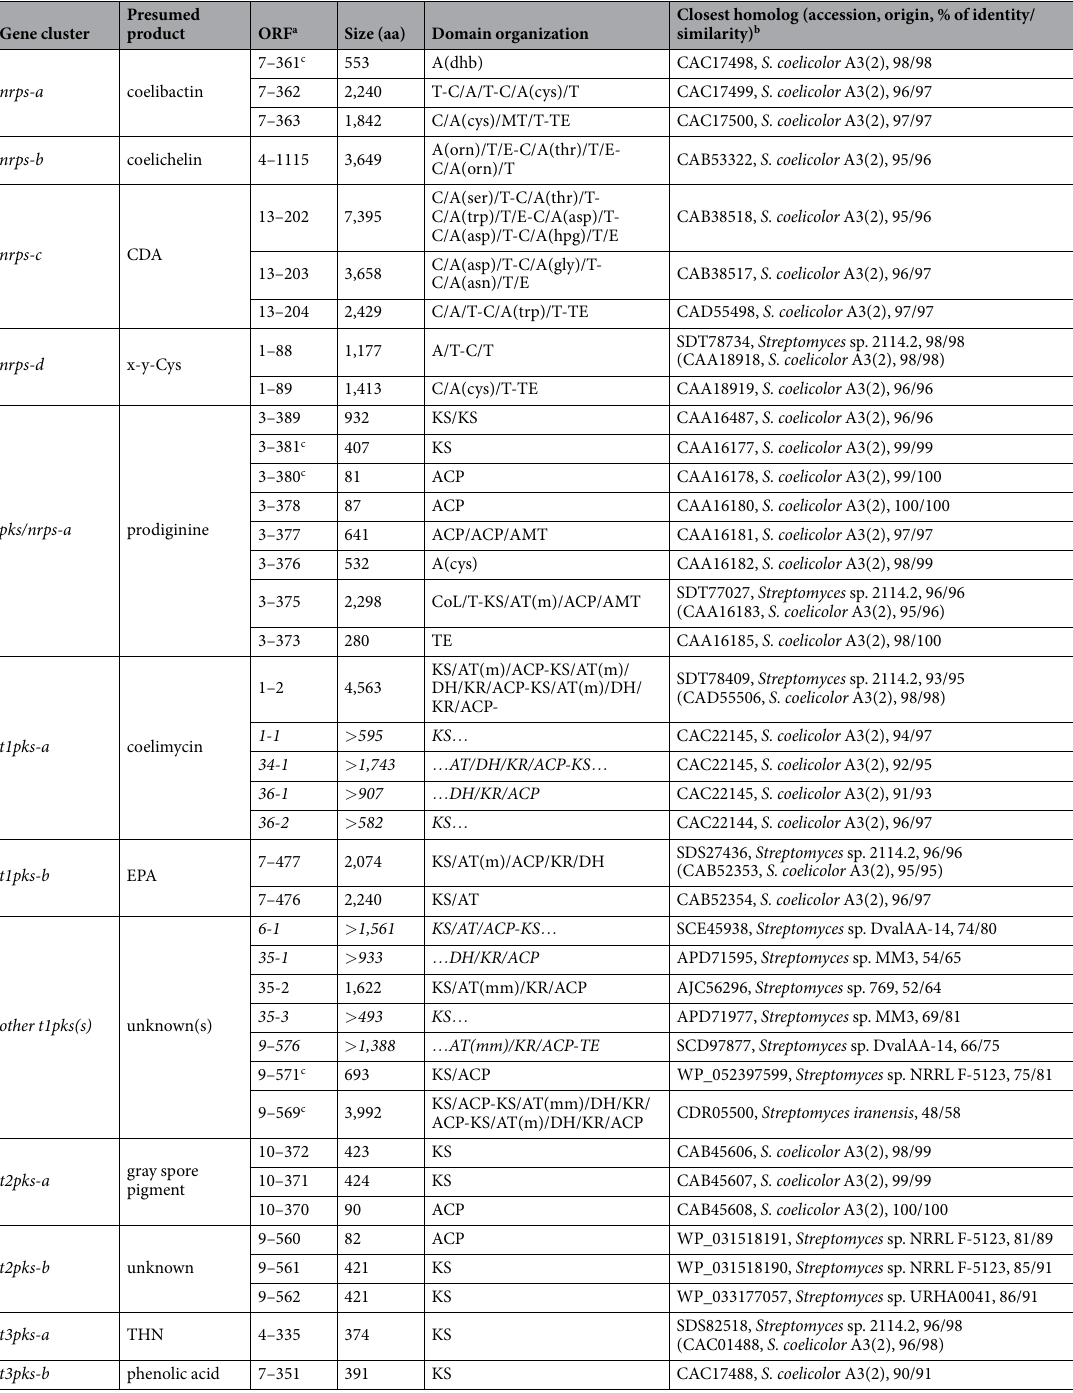
Table 6. ORFs encoding NRPSs and PKSs in NRPS and PKS gene clusters of S. rubrogriseus NBRC 15455 T . CDA, calcium-dependent antibiotic; EPA, eicosapentaenoic acid. The other abbreviations are the same as those of Table 2. a ORFs are shown as a combination of scaffold number and ORF number. Incompletely sequenced ORFs are shown in italics, and undetermined domains are shown as “ … ”. b Parentheses indicate that the closest homolog is not from S. coelicolor A3(2). c Encoded on the complementary